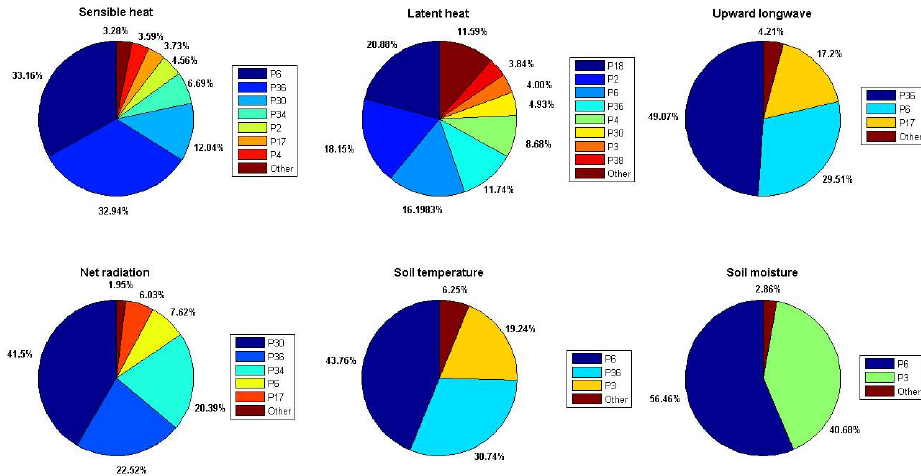
Fig. 12. The relative importance of parameters obtained by RSMSobol’ total effect analysis. Table 7. The cumulative importance of the 10 most sensitive parameters screened by different qualitative SA methods. SA